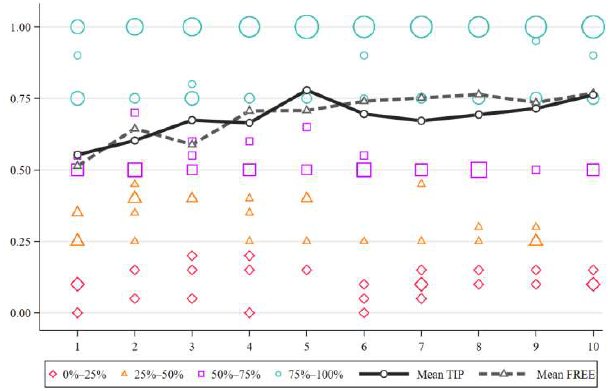
Figure 5. The investment made by player A in TIP. Circles represent choices above 75% of the total, squares represent choices of 50–75%, triangles represent choices of 25–50%, and diamonds represent choices below 25%. The solid line portrays the mean choices per period.